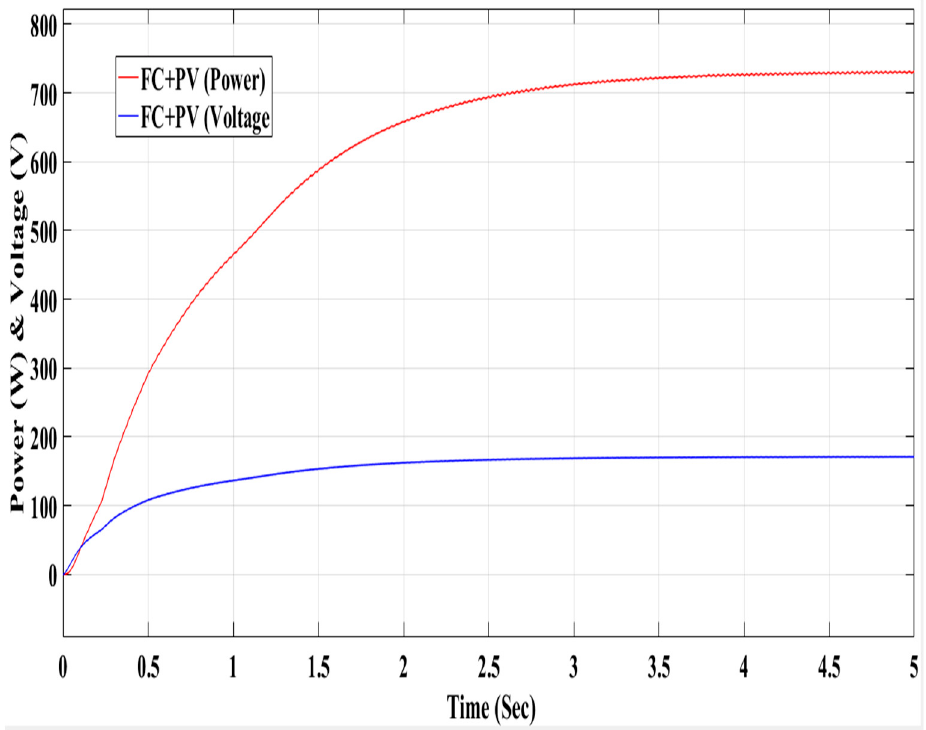
Figure 28. Power and voltage characteristics of the FC–PV model using a fuzzy logic controller.